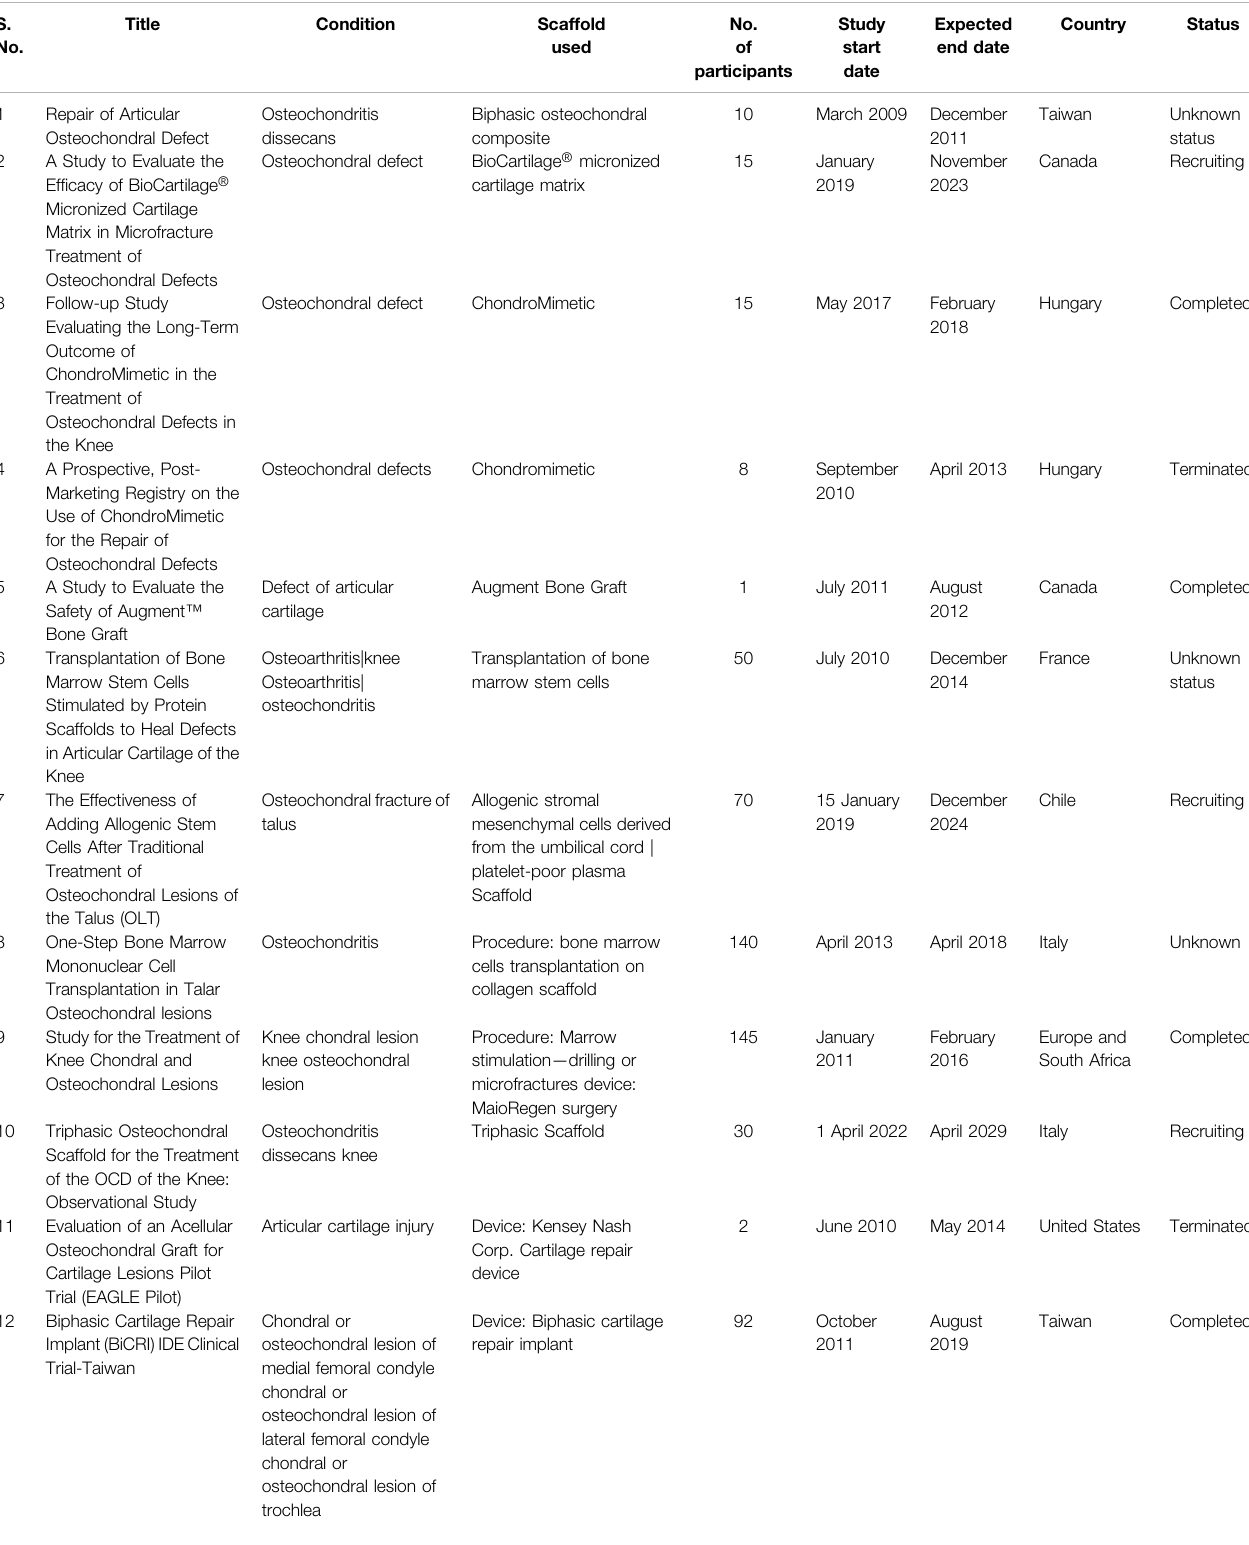
TABLE 2 | Clinical trials for osteochondral defects. S.